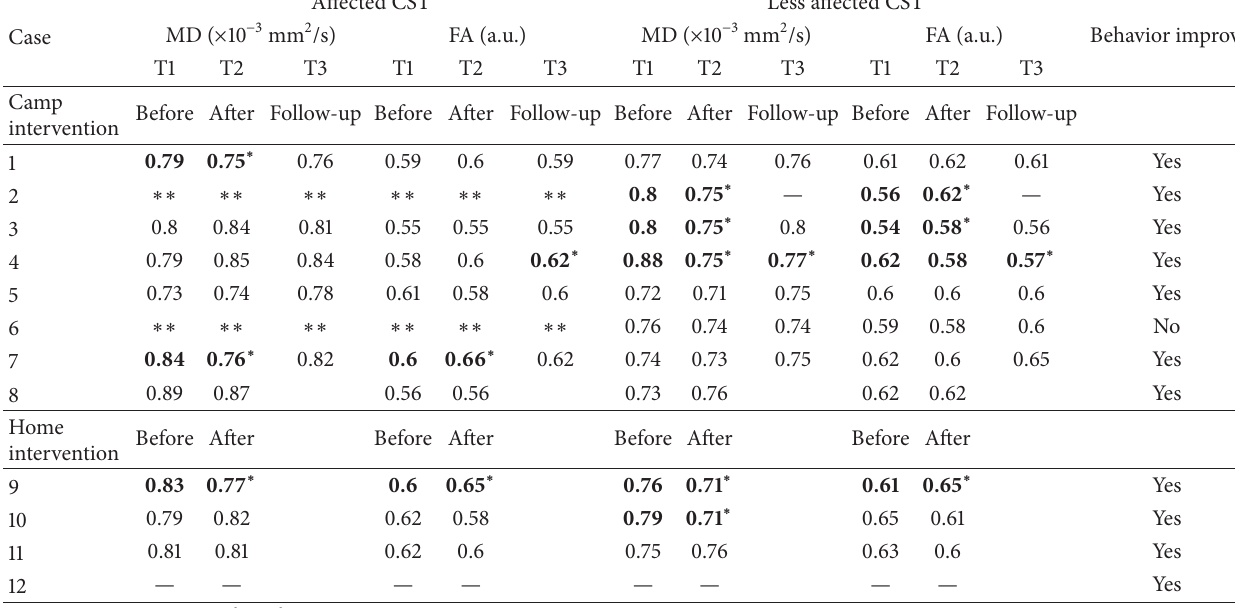
Table 5: Diffusivity parameters in the affected corticospinal tract at 3 time points. Affected CST Less affected